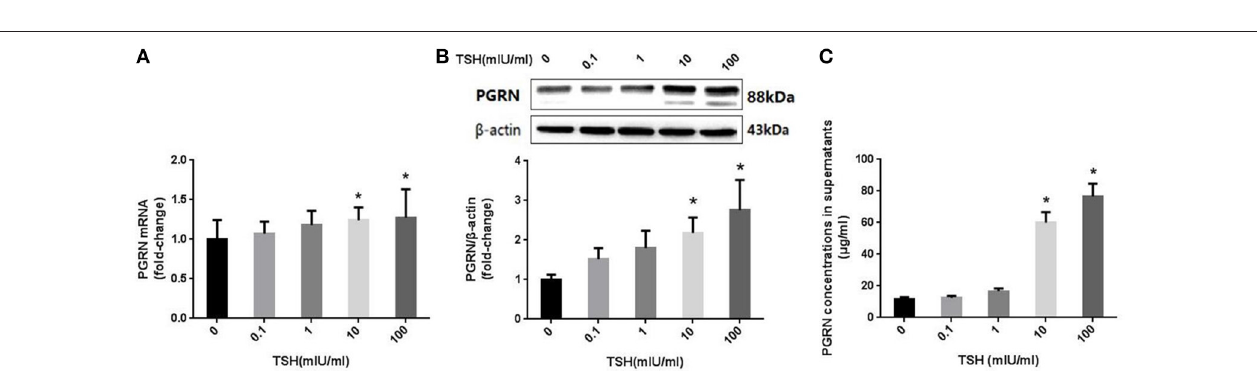
Frontiers in Endocrinology |